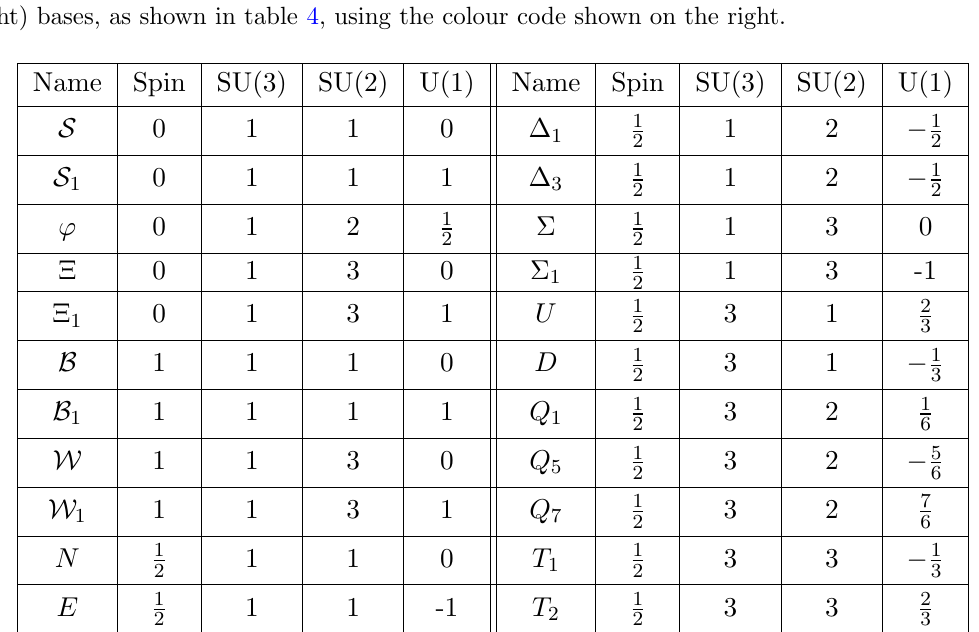
Figure 5. Matrices of correlations among the operator coe(cid:14)cients in the Warsaw (left) and SILH (right) bases, as shown in table 4, using the colour code shown on the right.